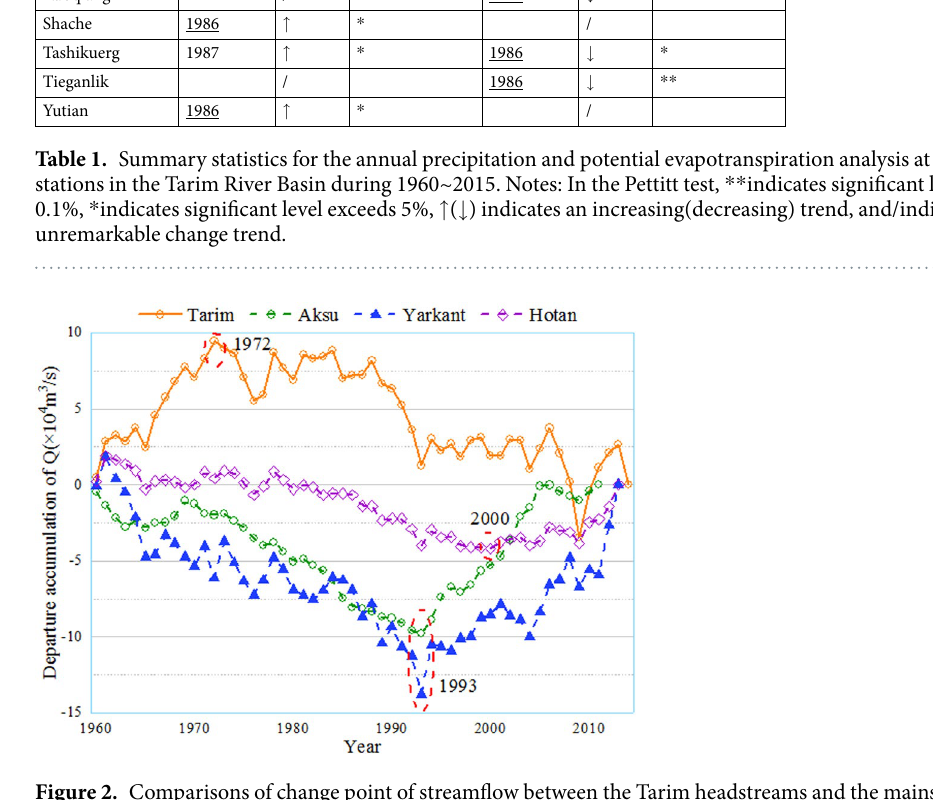
Figure 2. Comparisons of change point of streamflow between the Tarim headstreams and the mainstream during 1960~2015 (Note: lines represent the departure accumulation of streamflow with cumulative average deviation method. The streamflow in headstreams are observed at the Shaliguil in Aksu, the Kaqun in Yarkant and the Wuluwati in Hotan River, respectively. The streamflow in mainstream is observed at the Alar in the Tarim